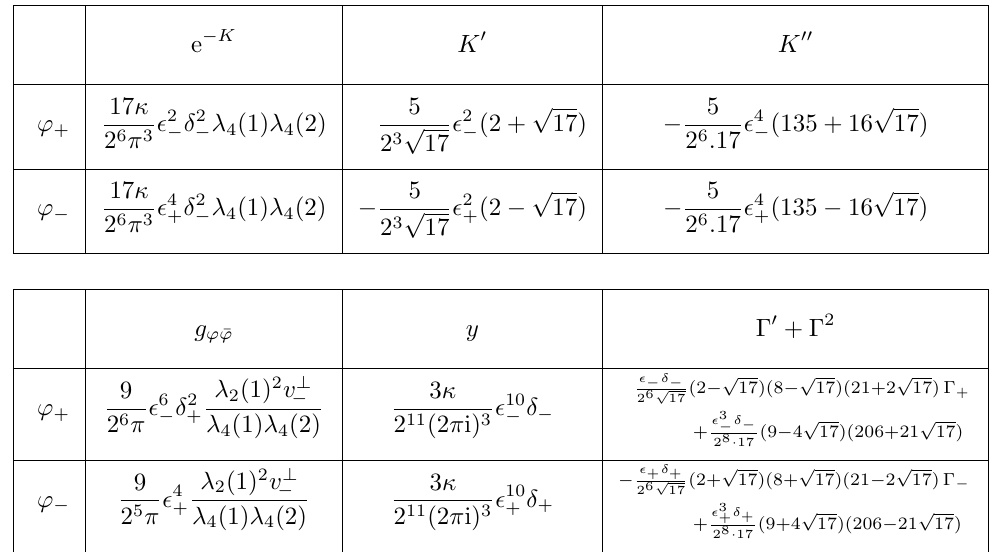
Table 9 . The values of quantities that enter into the calculation of the covariant derivatives of table 8. In this table (cid:0) (cid:6) denotes the Christo(cid:11)el symbols (cid:0) ’